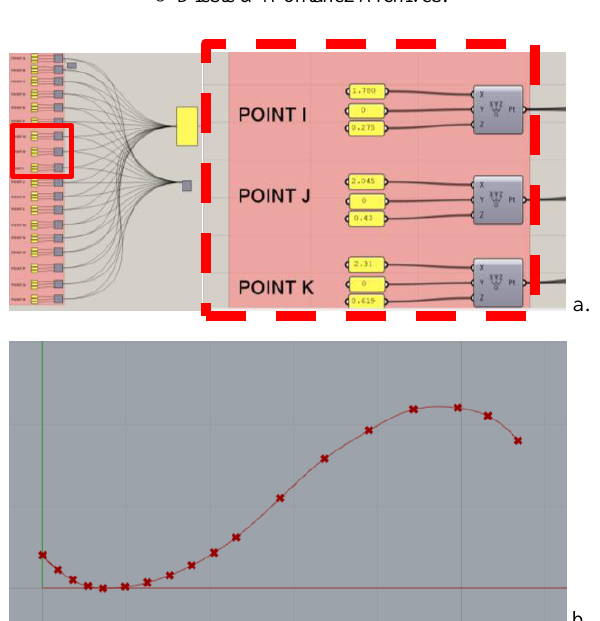
Figure 5: The ‘vault of the geometry’ tables have the point coordinates of each intersection between the transverse and longitudinal ribs of the gaussian vault’s roof formwork. © Dieste & Montañez Archives.